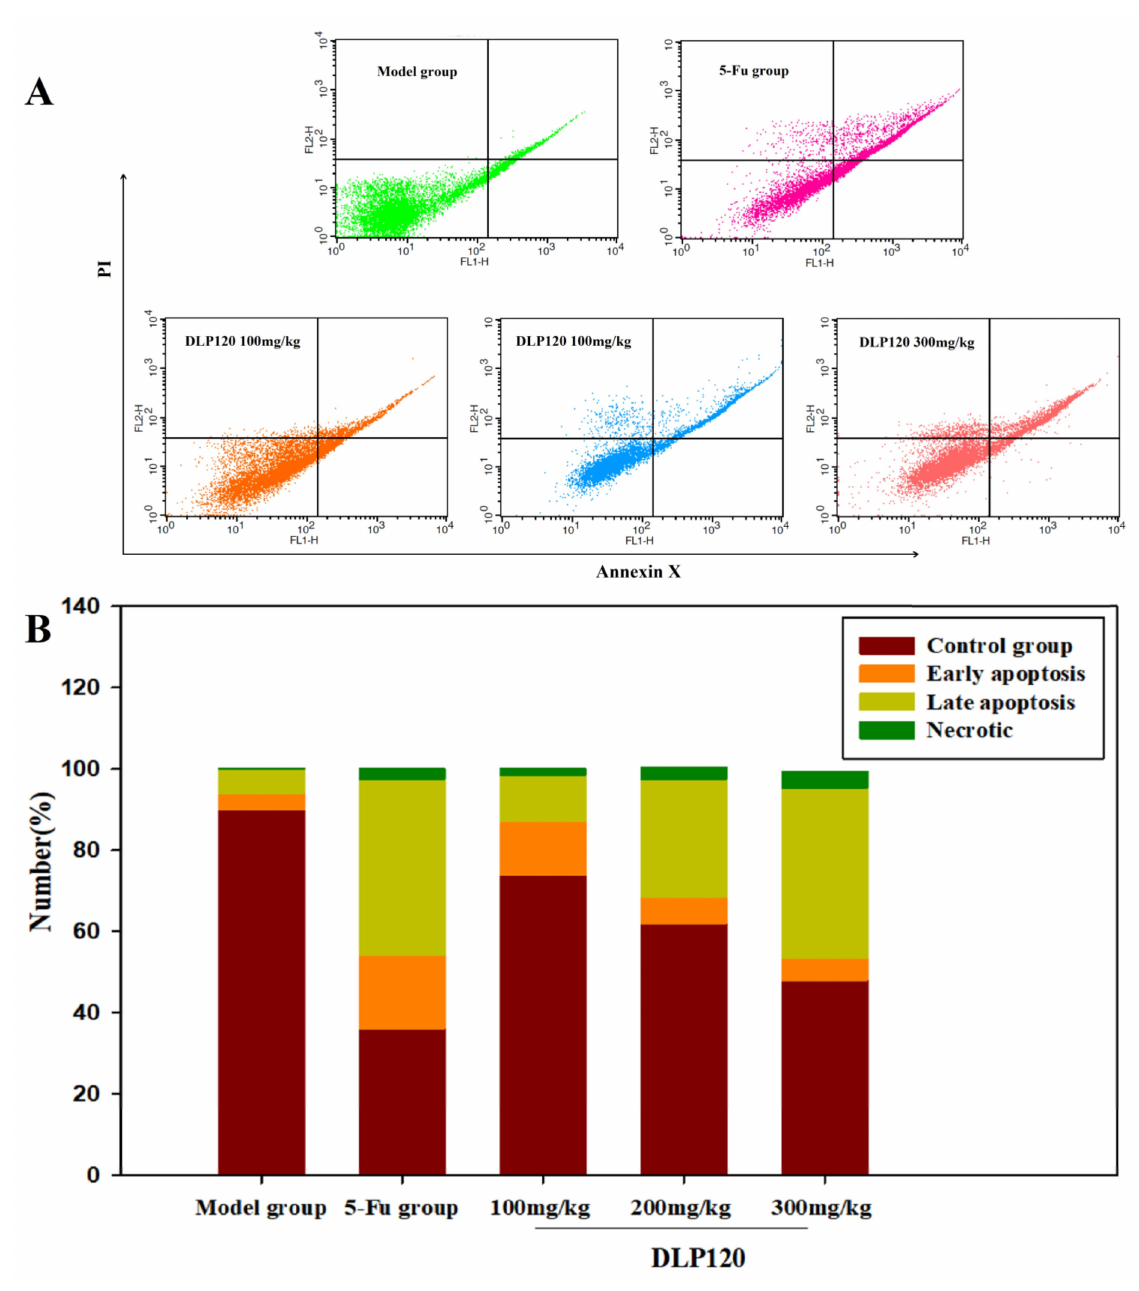
Figure 7. Distribution ( A ) and proportions ( B ) of tumor cell